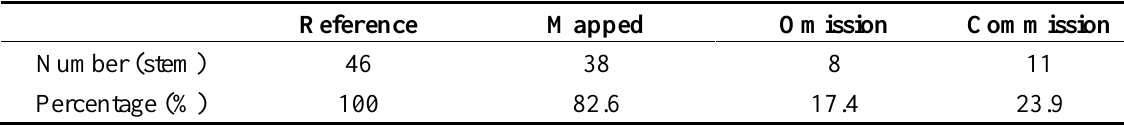
Table 4. Stem mapping accuracy utilizing the multipass-corridor-mapping method and PLS